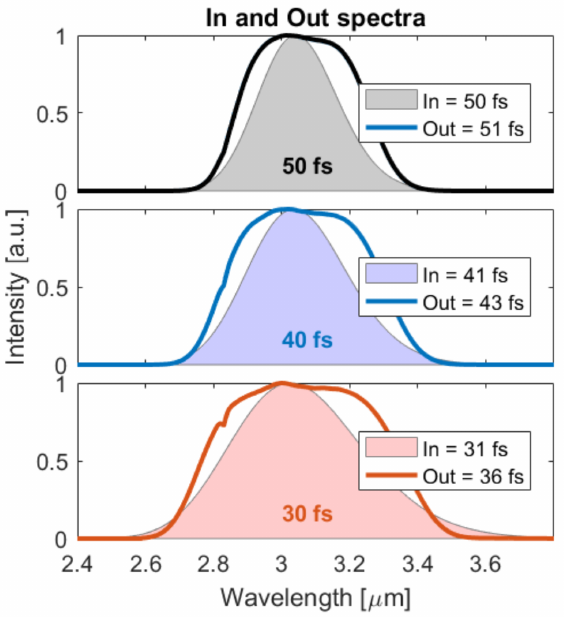
Figure 6. Input ( shaded ) and output ( solid line ) spectra for different seed bandwidths in a single MgO:LN-based amplification stage. ( Top ) 50 fs, ( Center ) 40 fs; ( Bottom ) 30 fs pulse